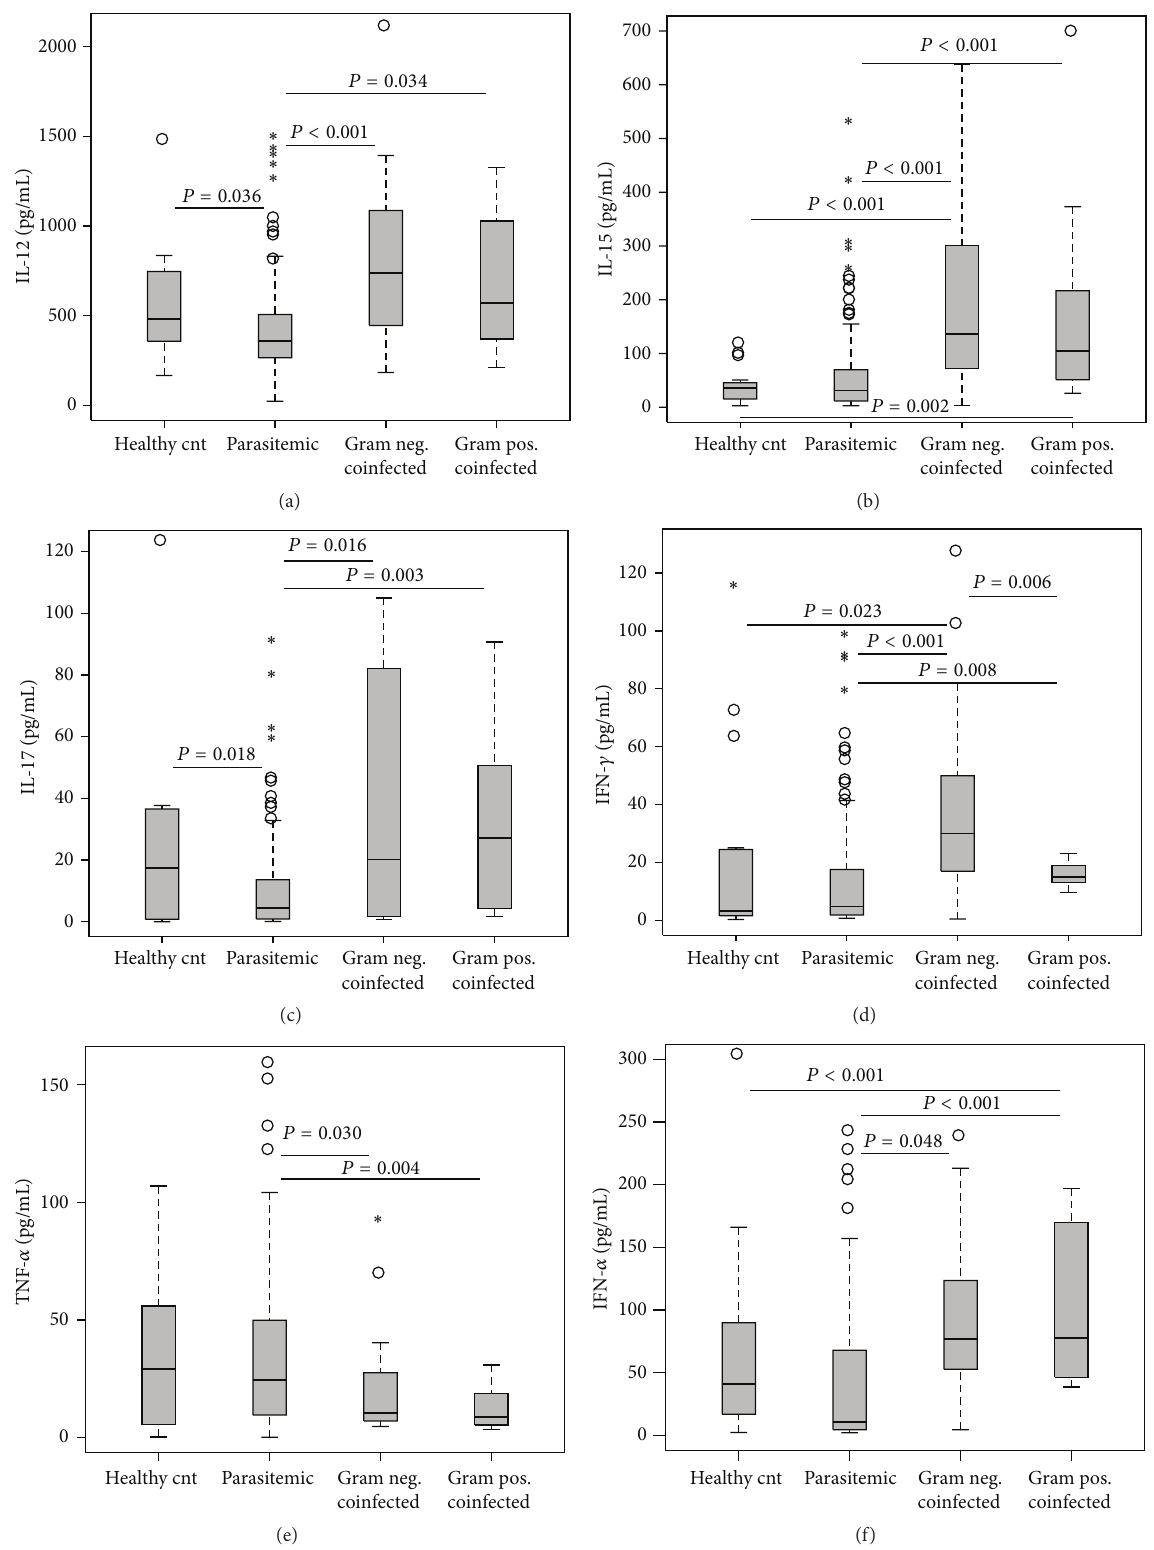
Figure 3: Proinflammatory mediator profiles. Data are presented as box plots with whiskers and outliers. The box represents the interquartile range, while the whiskers represent the 10th and 90th percentiles. The line across the box indicates the median value, open circles ( ∘ ) represent extremes, and asterisks ( ∗ ) depict outliers. Pair-wise comparisons between groups were conducted with Mann-Whitney 𝑈 test. All units are in pg/mL. (a) IL-12 (Kruskal-Wallis [K-W] test, 𝑃 < 0.001 ). (b) IL-15 (K-W test, 𝑃 < 0.001 ). (c) IL-17 (K-W test, 𝑃 = 0.002 ). (d) IFN- 𝛾 (K-W test, 𝑃 < 0.001 ). (e) TNF- 𝛼 (K-W test, 𝑃 = 0.003 ). (f) IFN- 𝛼 (K-W test, 𝑃 < 0.001